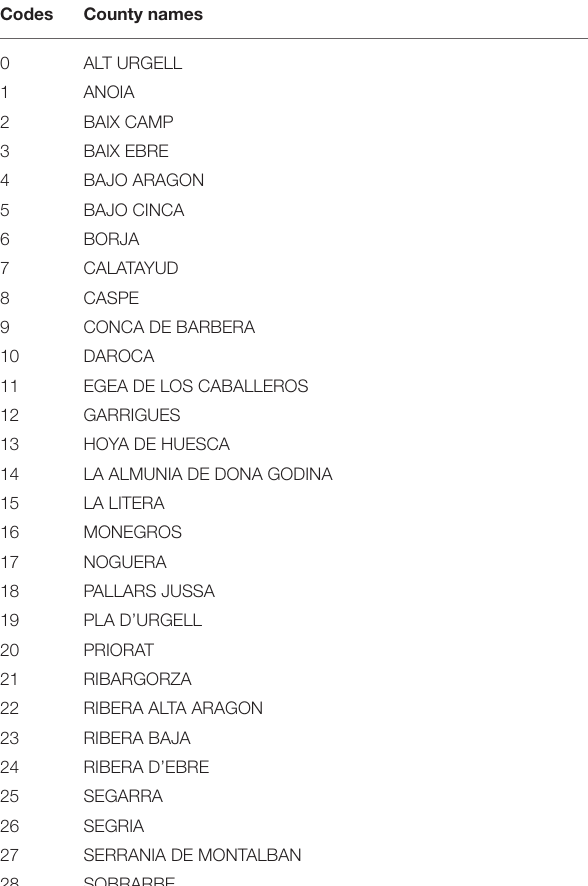
TABLE A1 | List of numerical county codes and corresponding names covered by the GSP monitoring system.